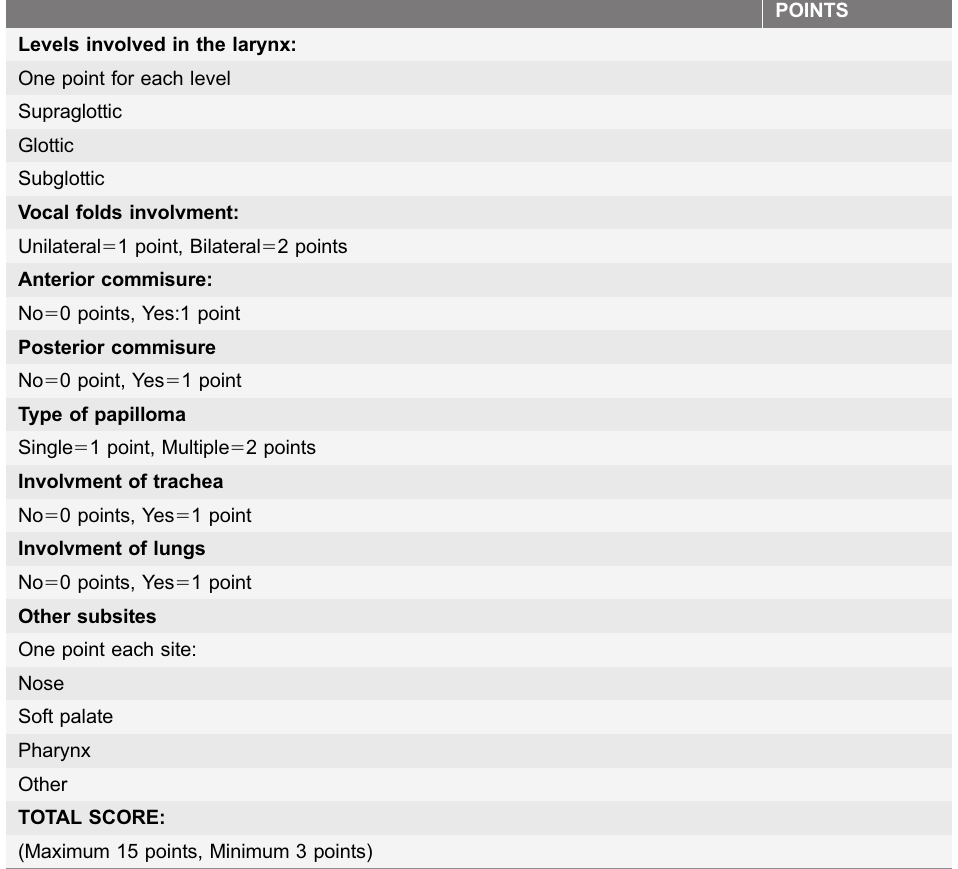
Table 1. Staging score system.